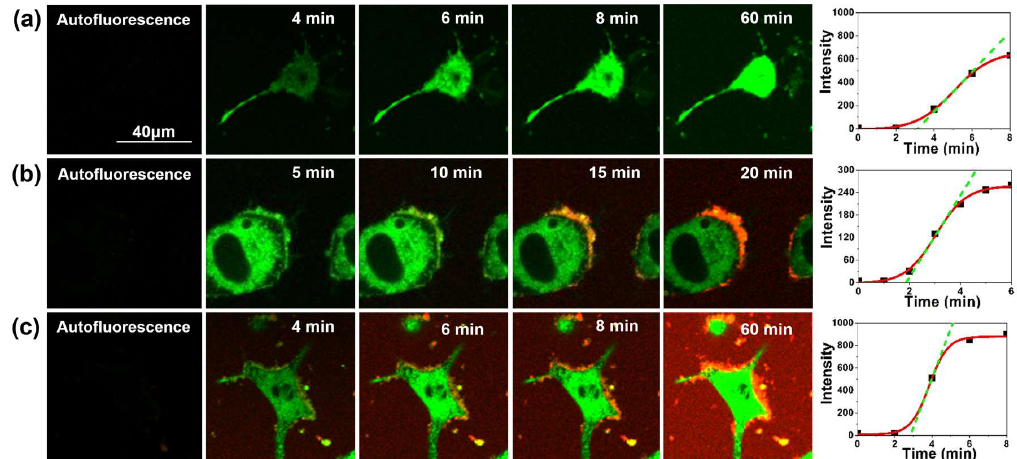
Int. J. Mol. Sci. 2020 , 21 , x FOR PEER REVIEW 10 of 19 Figure 5. Representative images of cellular stress assays with the biothiol probe (green channel) at different times without control, ( a ) or with the addition of Aβ-647 aggregates (red channel) previously incubated for 24 h ( b ) and 48 h ( c ). The plots in the rightmost column represent the corresponding average intensity per pixel value of the biothiol probe as a function of time along with the fitted sigmoidal function (red curve) and the slope at the inflection point (green, dashed line).